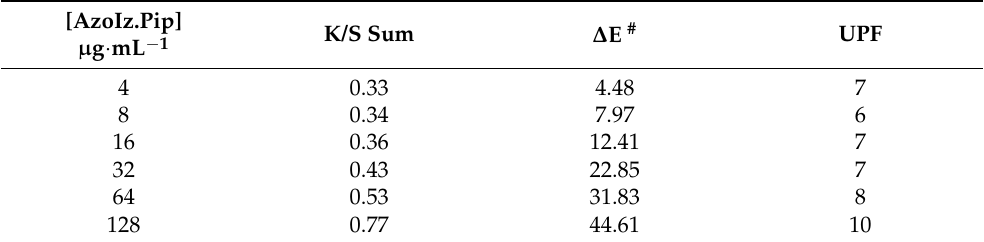
Table 7. K/S, ∆ E, and UPF values of the dyed silk samples with different concentrations of AzoIz.Pip under pH 6 and 40 ◦ C and immersed in a Britton–Robinson solution at pH